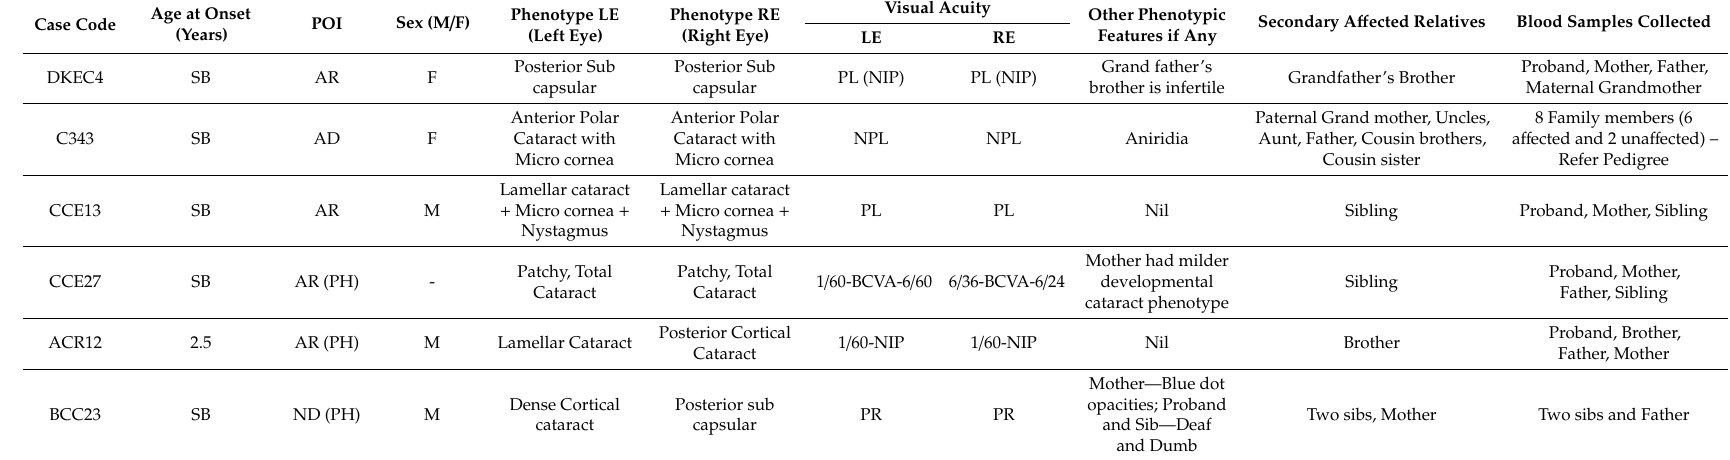
Table 1. Summary of Clinical findings in resolved Bilateral Childhood Cataract Cases of the present